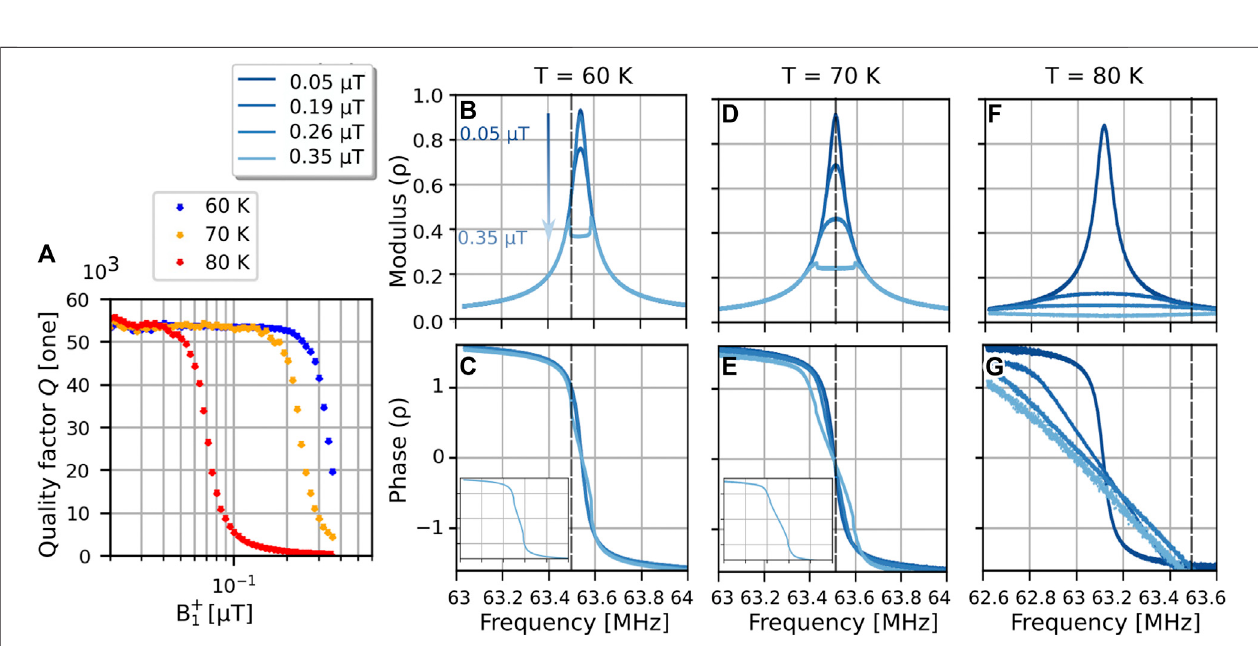
Frontiers in Physics |